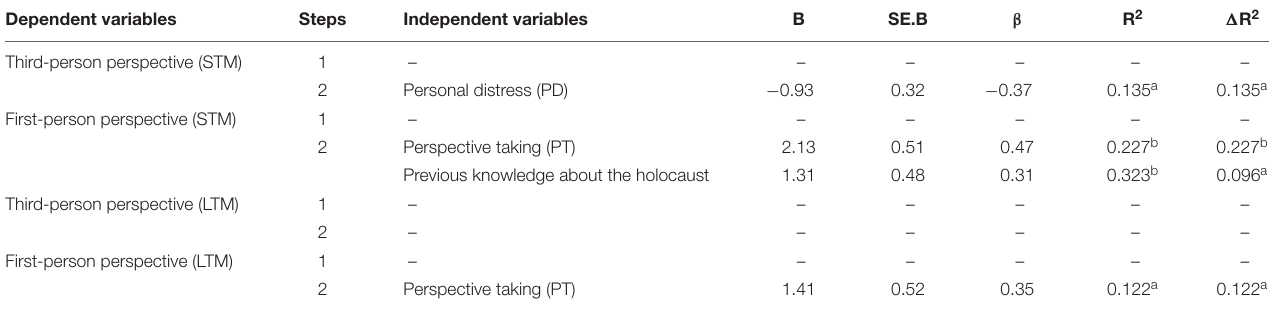
TABLE 3 | Results of hierarchical regressions for the performance on the memory tests by the PSTs gender, age, their previous knowledge about the Holocaust and their scores on the four IRI subscales. Dependent